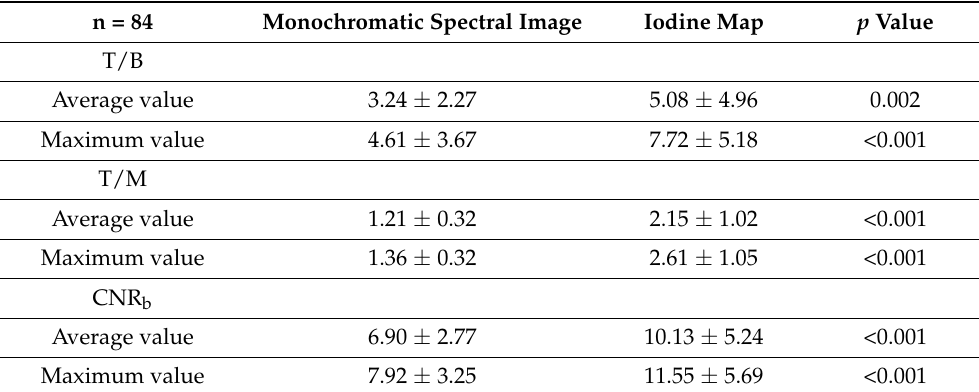
Table 2. Average and maximum T/B, T/M, and CNR b obtained from monochromatic spectral images and iodine maps for all breast densities.